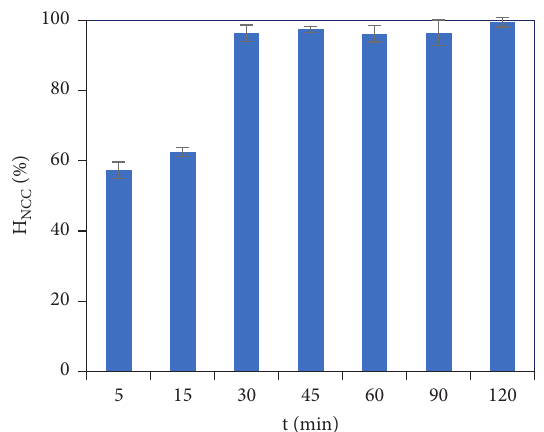
Figure 9: Effects of the absorbate dosage on the NCC adsorption onto the PVBTAC-modified α -Al 2 O 3 particles with C i ,NCC of 10ppm, pH 8, NaCl 10mM and m α -Al2O3 of 3mg mL − 1 .